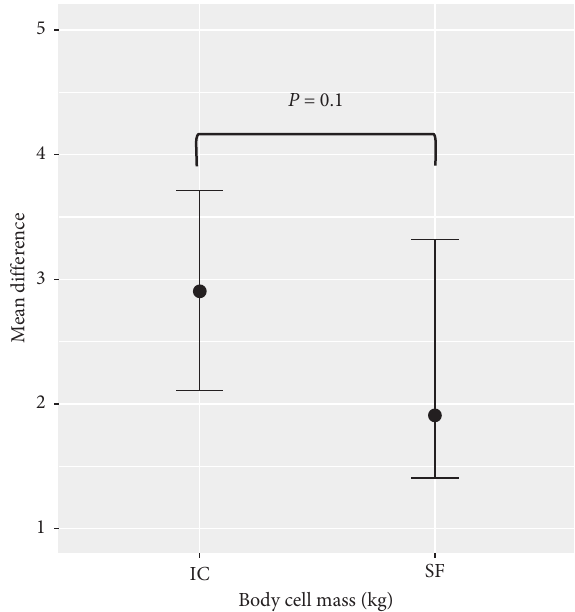
Figure 2: Comparison of mean differences of body cell mass between indirect calorimetry (IC) and Schofield equation (SF). Using either IC or the Schofield equation to estimate the target caloric goal could preserve muscle mass during PICU admission (Wilcoxon signed-rank test, p � 0 .